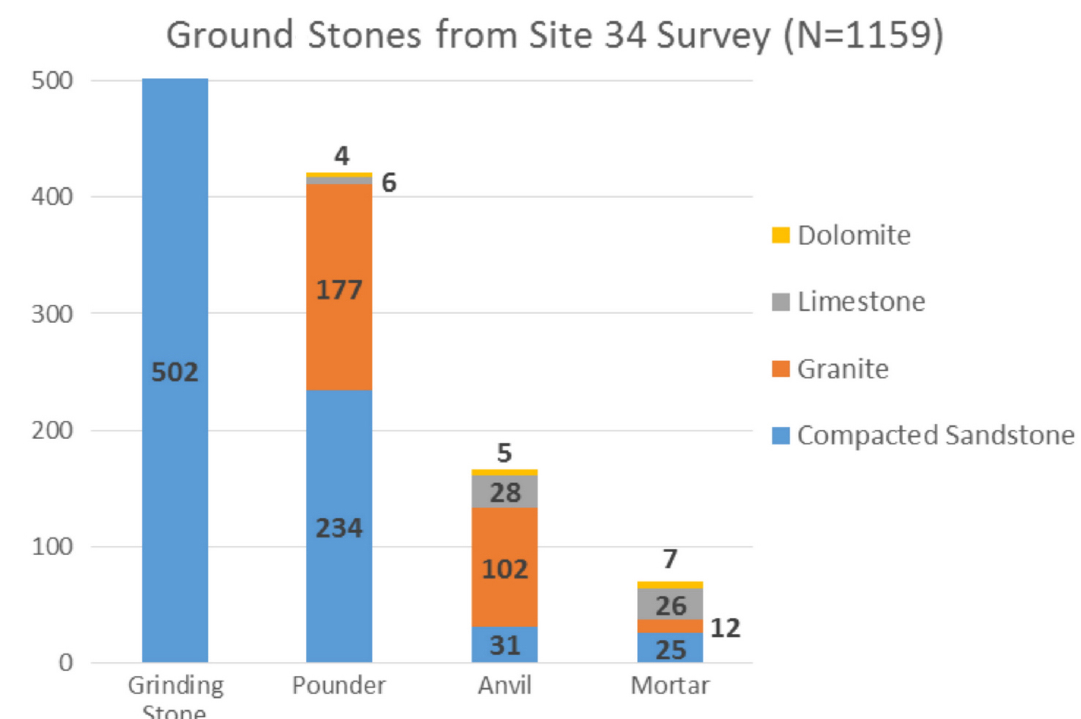
Figure 19. Rock type frequencies of ground stone assemblage found at Site